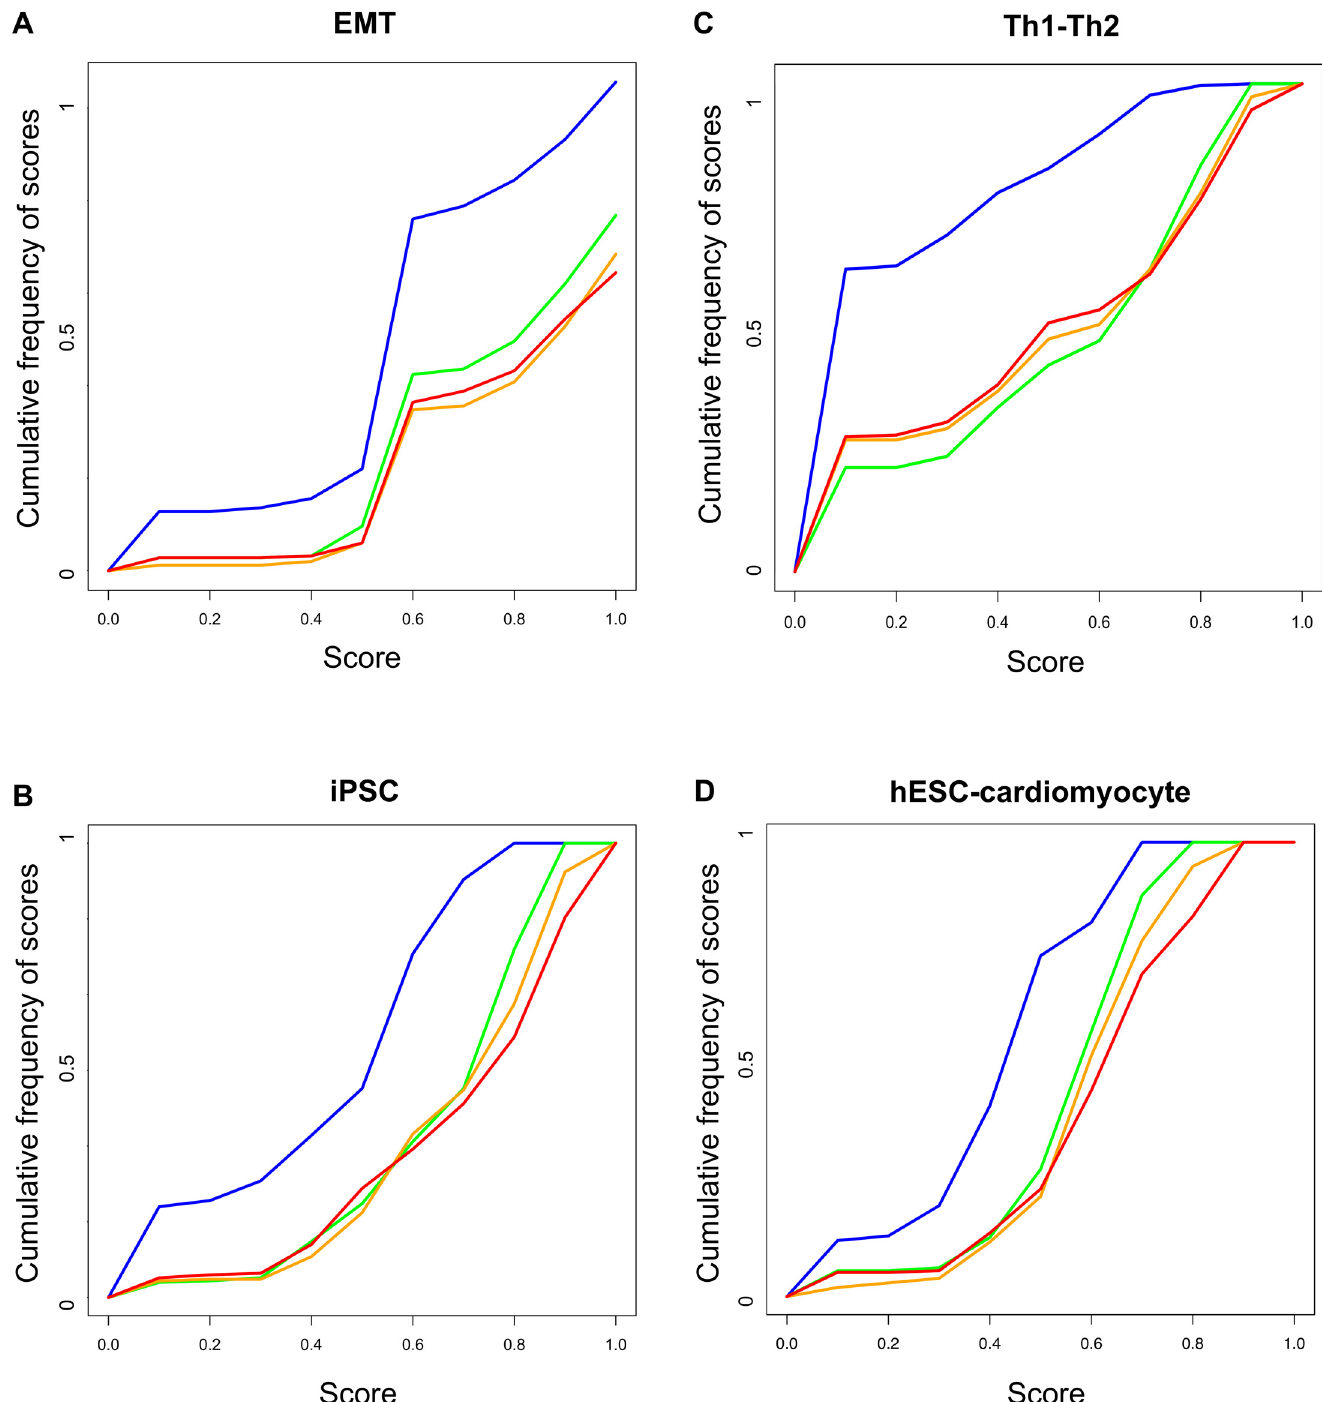
Fig 4. Validation of PRUNET using four biological examples. The scores obtained after the application of PRUNET to four biological examples, namely epithelial to mesenchymal transition (EMT), Th1-Th2 transdifferentiation (Th1-Th2), induced pluripotent stem cells (iPSC) and cardiomyocyte differention of human embryonic stem cells (hESC-cardiomyocyte), were compared with the scores obtained by a population of randomly generated subnetworks from the prior knowledge network. Green, orange and red lines represent the cumulative frequencies of scores obtained with training sets of a half, an intermediate number (different for each case) and all of the genes respectively, whereas the blue line represents the scores obtained from the population of subnetworks randomly generated from the prior knowledge network. The separation between blue and the other lines represents the contribution of PRUNET to the prior knowledge network in terms of describing the known phenotypes of different training set